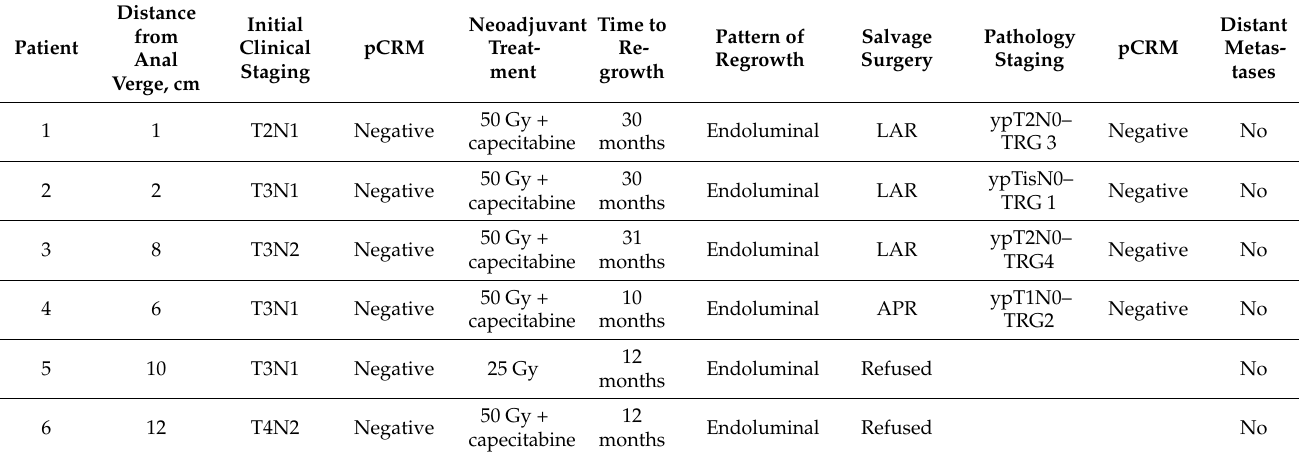
Table 4. Clinical characteristics of patients with local regrowth and subsequent salvage surgery.